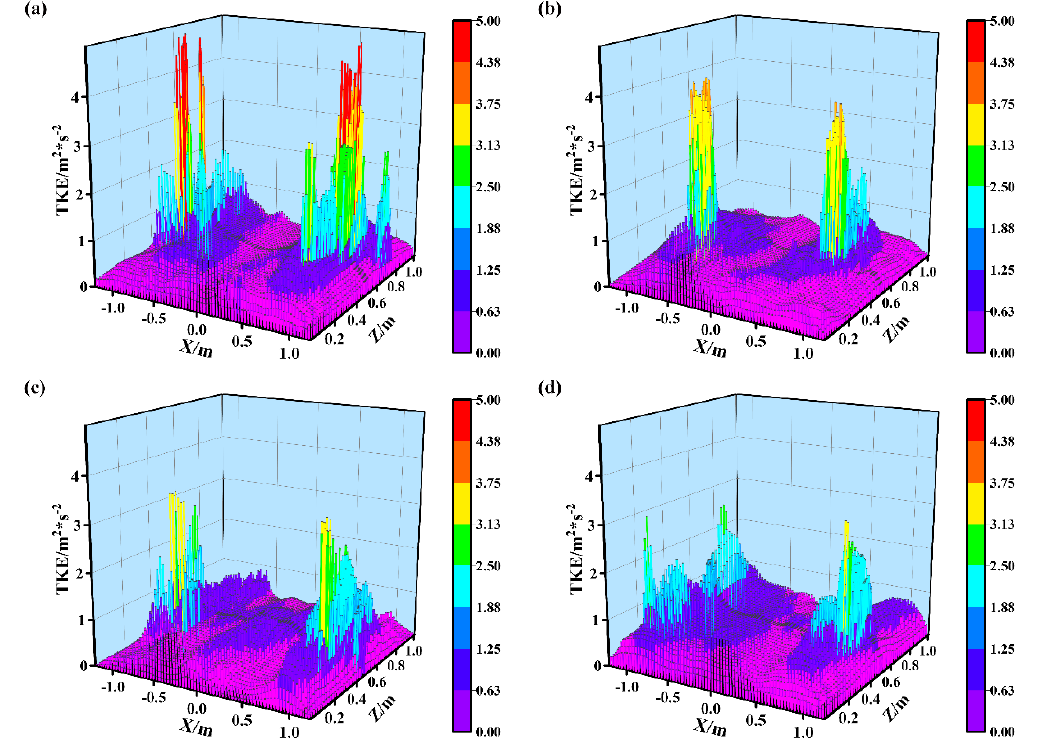
Figure 12. TKE at different initial liquid level, ( a ) liquid level 2.1 m; ( b ) liquid level 2.3 m; ( c ) liquid level 2.5 m; ( d ) liquid level 2.7 m.